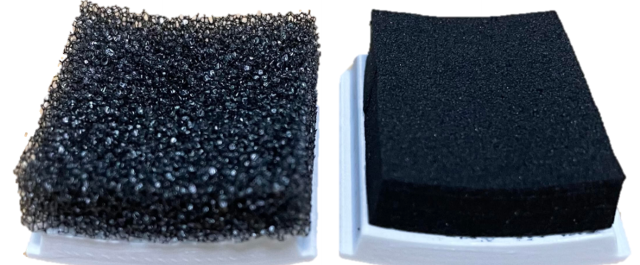
Figure 13. Two types of foam are compared in this paper: polyurethane or PU (left) and blended ethylene propylene diene monomer (EPDM)